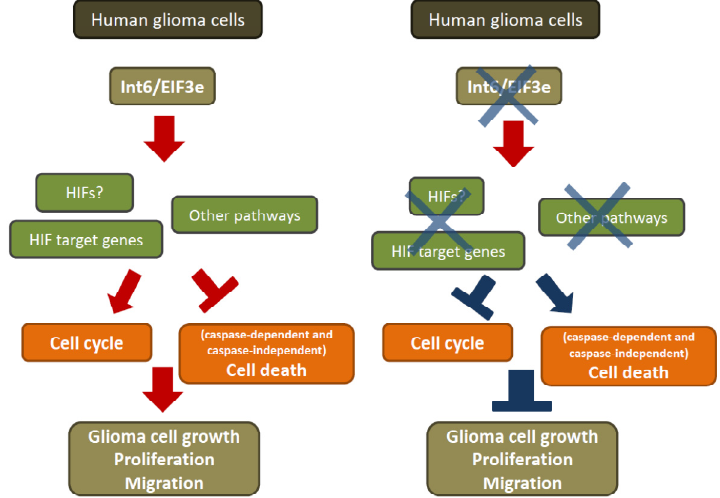
Figure 7. Int6/eIF3e is essential for human glioblastoma cell growth. Int6 inhibition leads to decreased glioma cell proliferation and migration, presumably through decreased HIF expression and activity and increased cell cycle arrest and